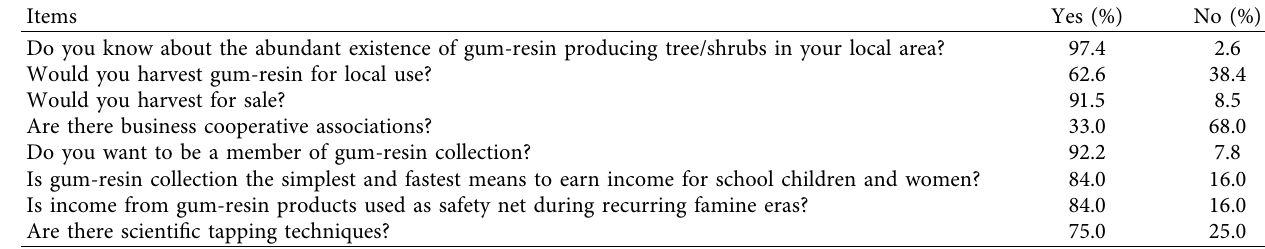
Table 6: Views of respondents on the future gum-resin resources management and commercialization.